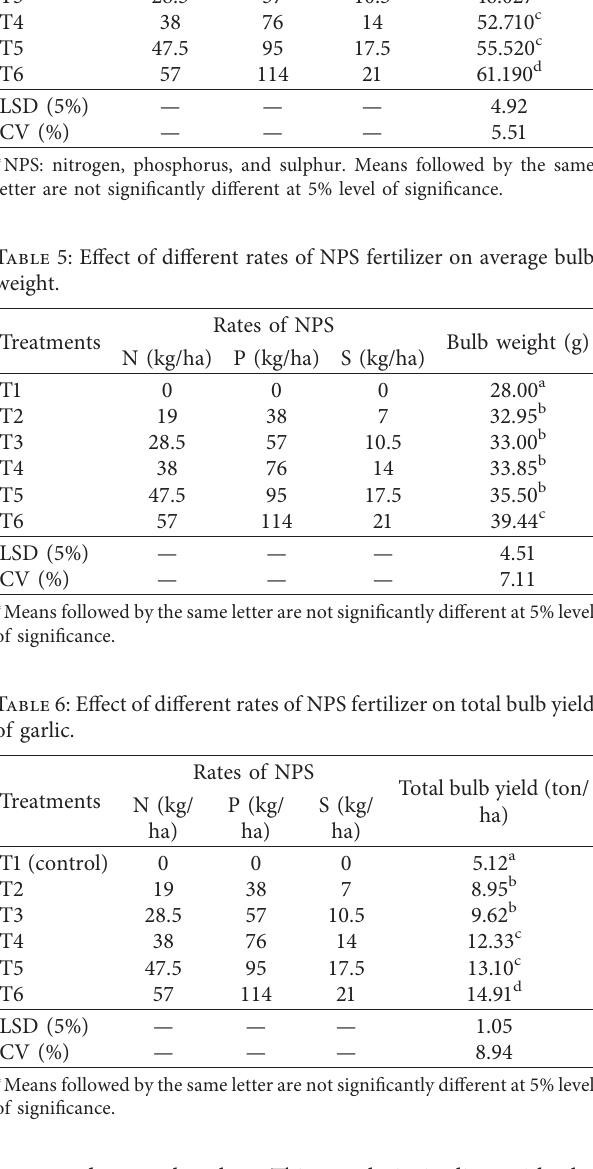
obtained from T6 (57:114:21kg/ha NPS) followed by T5 (47.5:95:17.5kg/ha NPS) and T6 (38:76:14kg/ha NPS). The plant height (61.19cm), average bulb weight (39.44g), and total bulb yield were obtained from T6 (57:114:21kg/ha NPS).